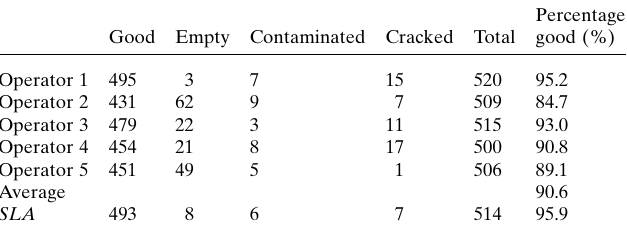
Table 1 Hole analysis for each square image for the 3 mApof grids imaged by Smart Leginon Autoscreen ( SLA ) and the 5 expert microscope operators (and their average). Figs. S9–S14 show the annotated hole magnification images.